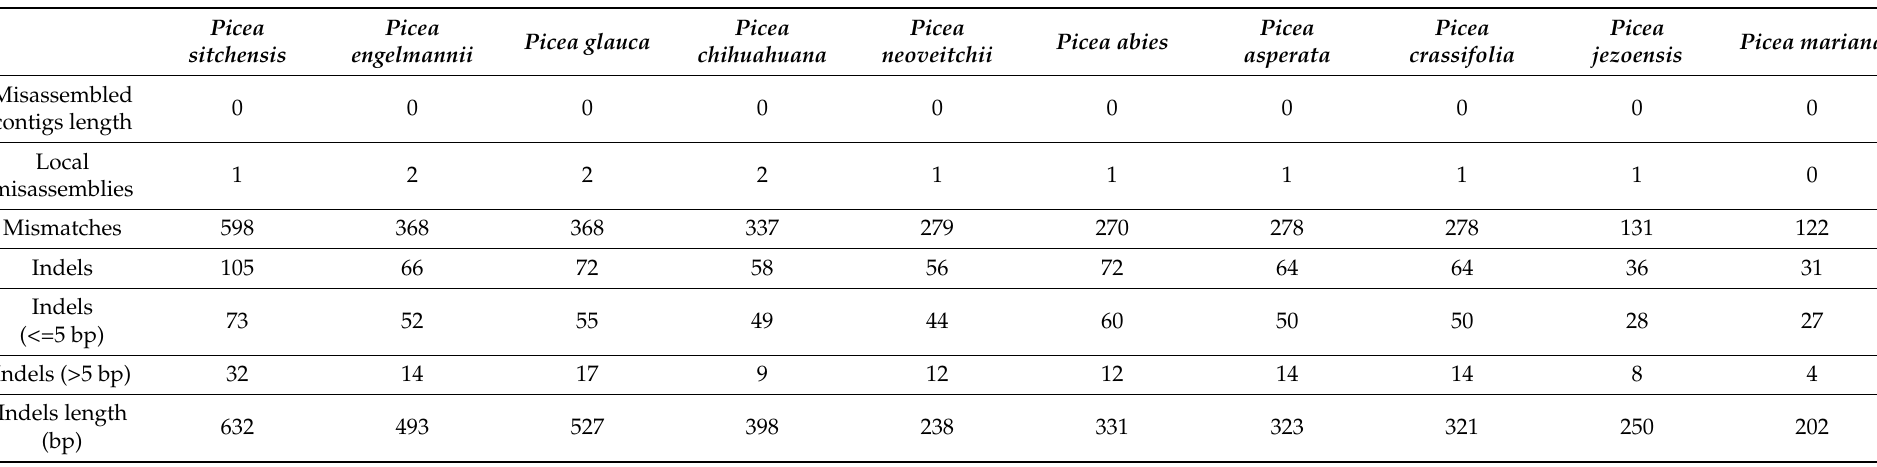
Table 1. QUAST (Quality Assessment Tool for Genome Assemblies) analysis for genome assembly report of the chloroplast genome of P. rubens with the